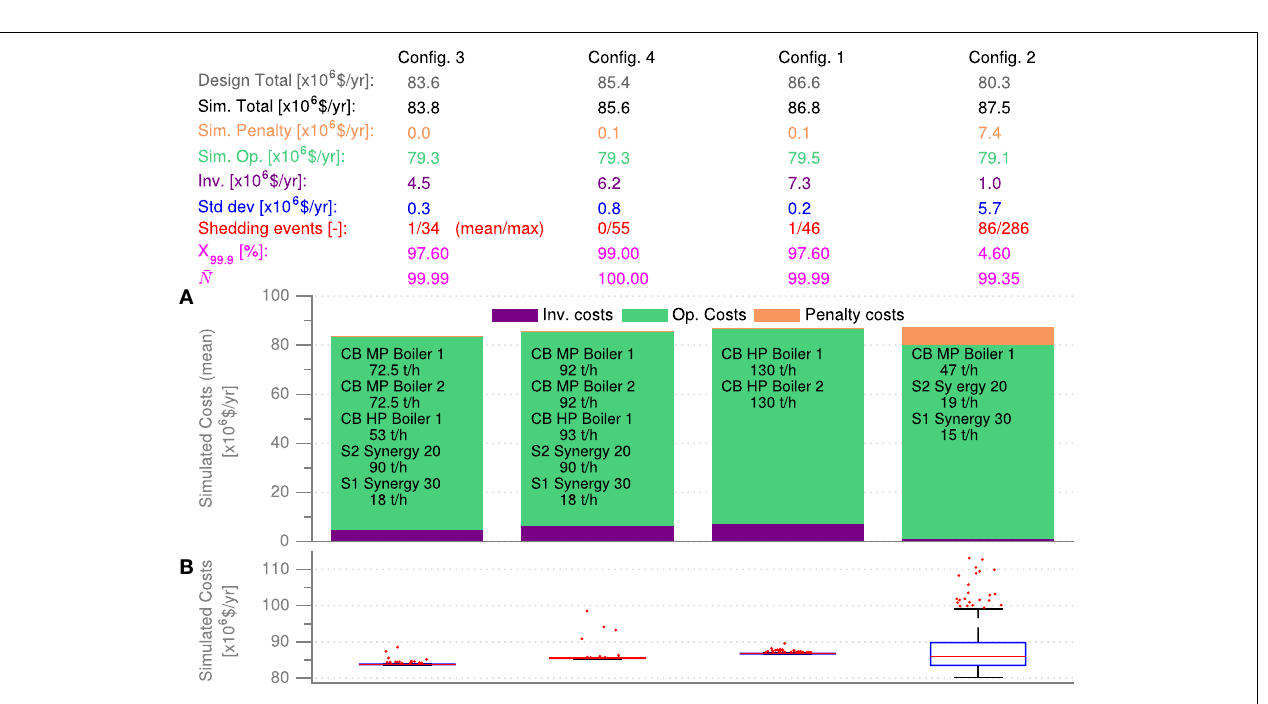
FIGURE 10 | Comparison simulation results for each configuration . Expected costs (A) and variation analysis (B)